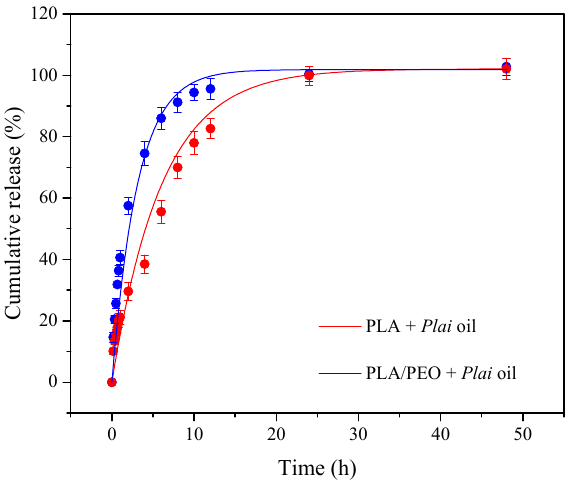
Figure 5. Cumulative release of DMPBD from the Plai oil-loaded fibrous membranes.